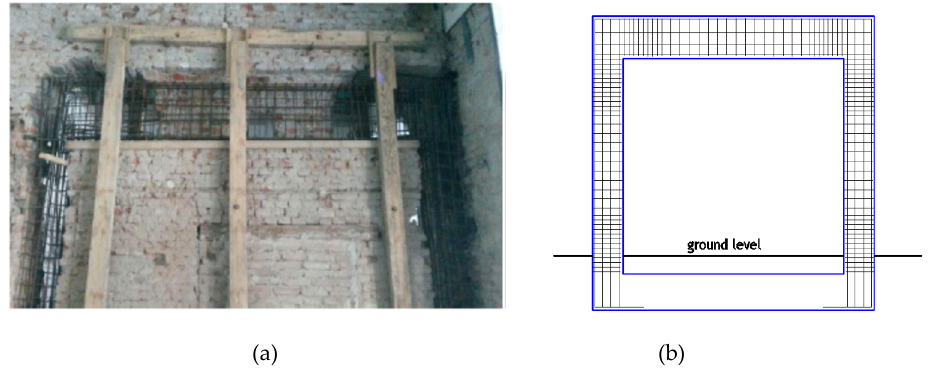
Figure 11. New RC frames were constructed as a part of the seismic retro fi tt ing of the Diocese in Pan č evo: ( a ) formwork and sca ff olding arrangement and ( b ) frame reinforcement detailing. Panˇcevo: ( a ) formwork and scaffolding arrangement and ( b ) frame reinforcement